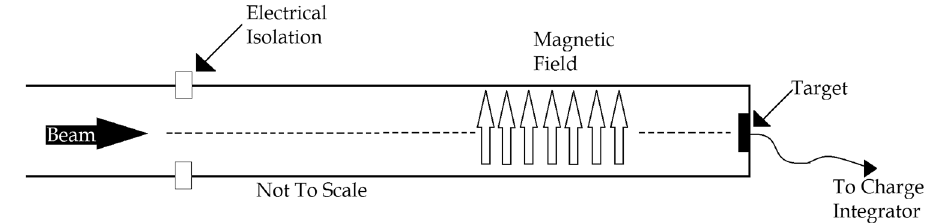
Figure 5. Schematic of the target mount for the 16 O and 28 Si irradiations. Not to scale. With the exception of the magnetic field, which is applied externally, there is radial symmetry about the dashed line. Everything downstream of the electrical isolation is electrically connected to the charge